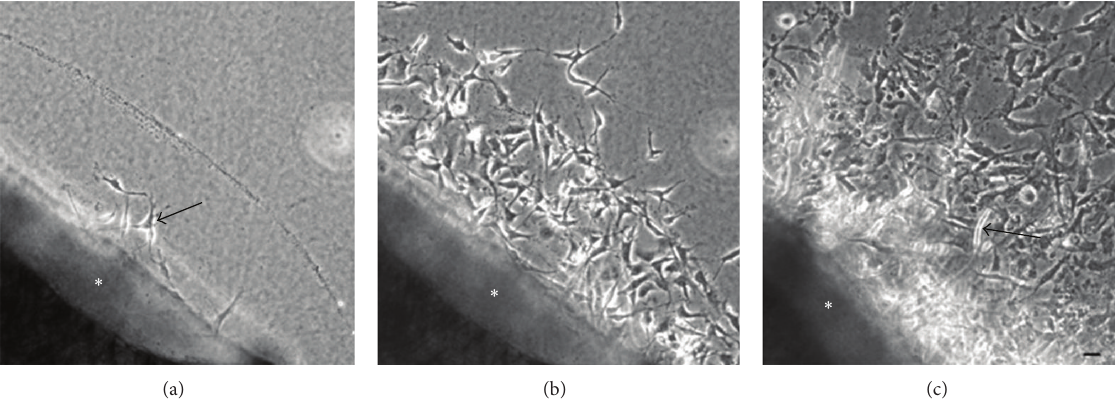
Figure 1: Phase-contrast microscopy. (a) After 2 days of cultivation, phase-contrast microscopy revealed fibroblastic cells (arrow) outgrown from a mouse aortic explant ( ∗ ) into a three-dimensional collagen gel. (b) After 5 days of cultivation, phase-contrast microscopy showed numerous fibroblastic cells outgrown from an aortic explant ( ∗ ). (c) After 7 days of cultivation, phase-contrast microscopy showed a tubular structure protruding (arrow) from an aortic explant ( ∗ ) into a three-dimensional collagen gel. (a), (b), and (c): Scale bar = 20 𝜇 m.